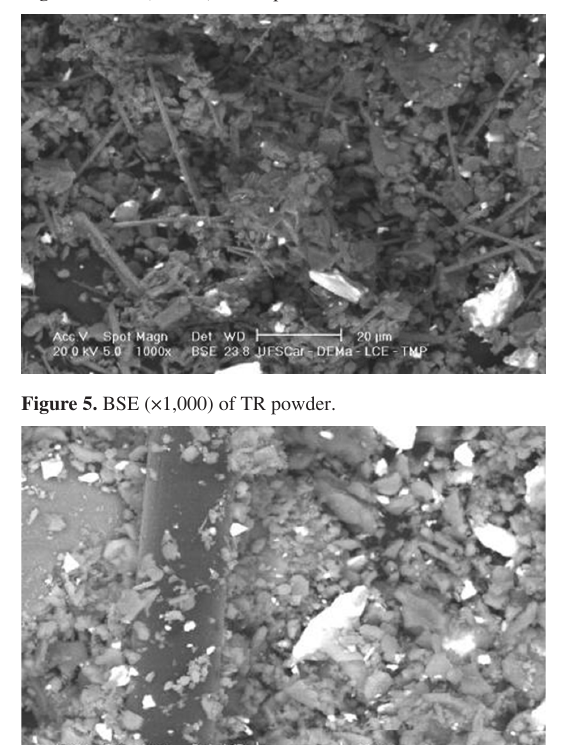
Figure 4. BSE (×1,000) of RU powder.